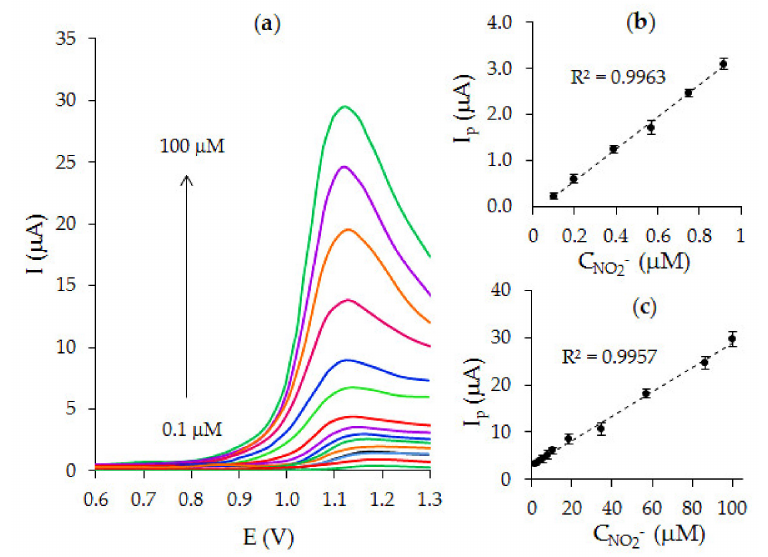
Figure 11. Linear sweep voltammograms of the TrX100 / FCVE at di ff erent nitrite concentrations ( a ) and corresponding dependences I p vs. C NO2 − on the TrX100 / FCVE ( b , c